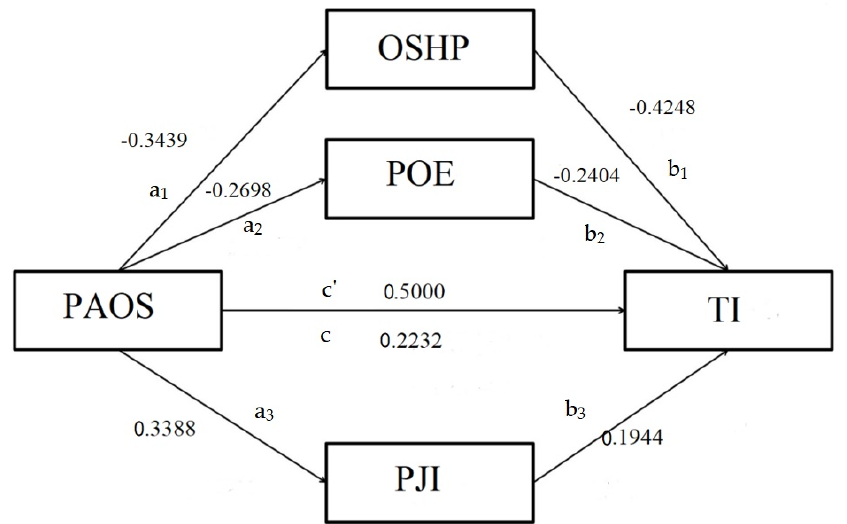
Figure 3. Parallel mediation analysis comparing the indirect effects of OSHP, POE and PJI. N = 324 The a, b and c paths represent regression coefficients that are all significant in terms of 95% bias- corrected confidence intervals that do not contain zero (5000 bootstrapped samples). c = total effect, c ′ = direct effect (when a and b are accounted for).